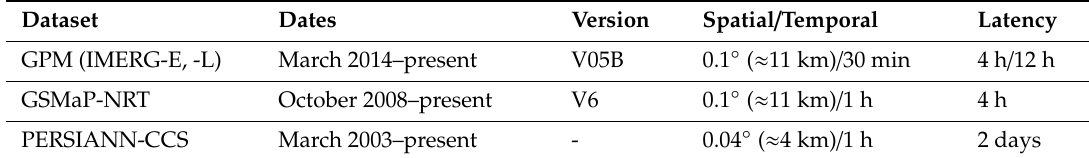
Table 1. Characteristics of satellite rainfall products used in the present